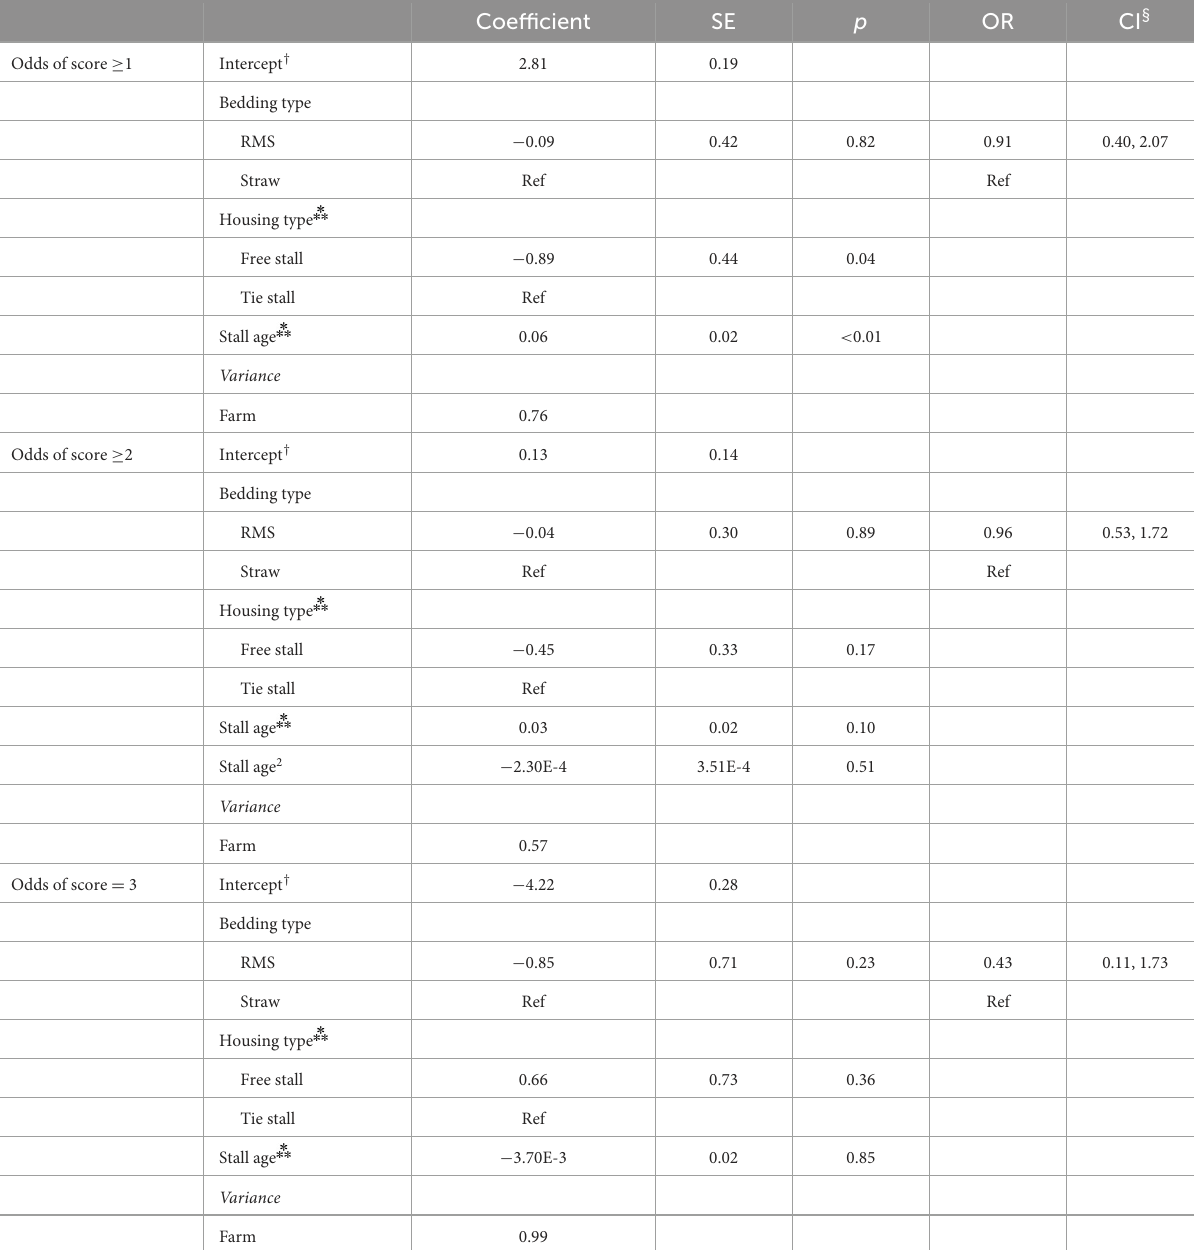
TABLE 7 Hock lesions odds ratio comparing cows housed on recycled manure solids bedding to straw-bedded cows, and estimated using continuation-ratio mixed model. Coefficient SE p OR CI § Odds of score ≥